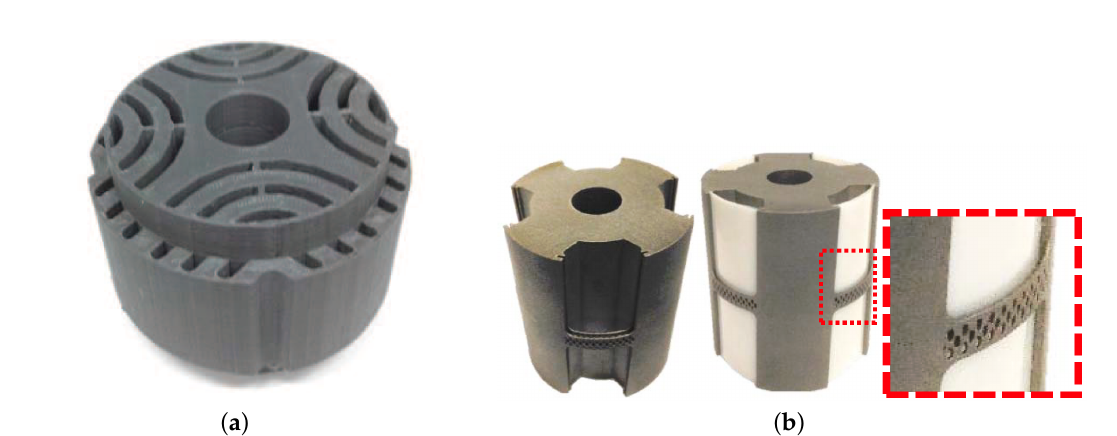
Figure 1. Additive manufactured rotor cores. These structures were fabricated without molding and tooling. ( a ) Printed rotor core for a synchronous reluctance machine [21]; ( b ) Printed rotor core for a switched reluctance machine